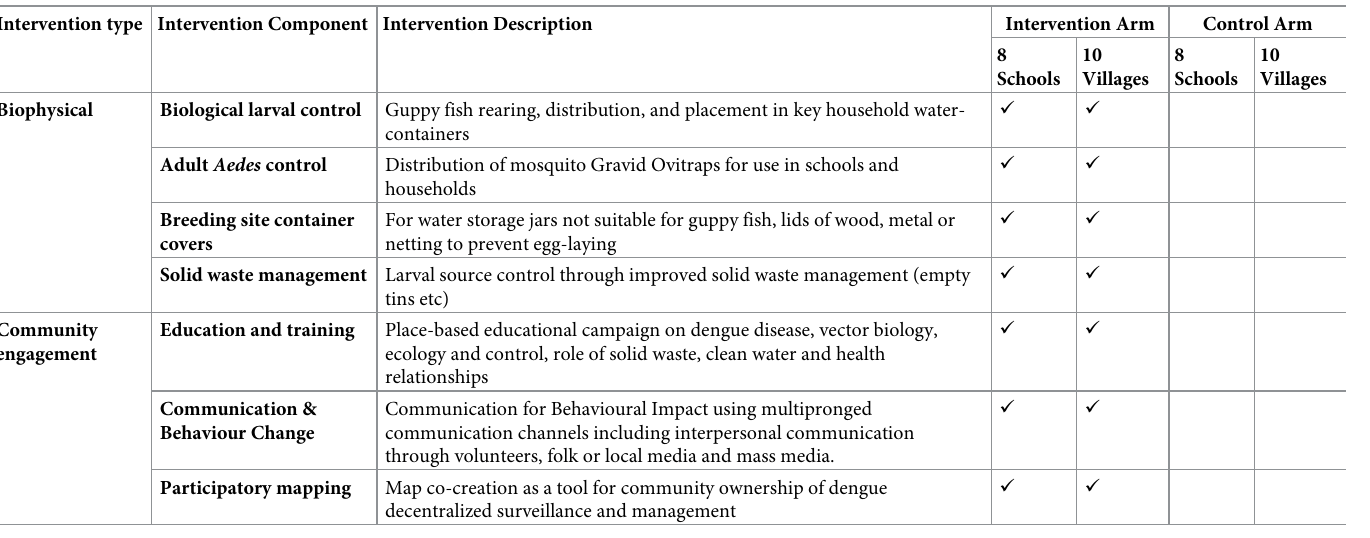
Table 1. Trial design: Interventions implemented in each trial